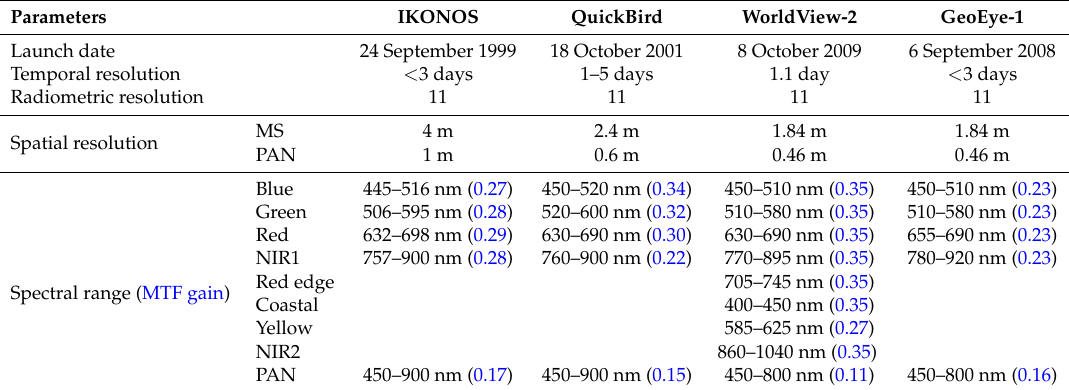
Table 1. Parameters of different satellites. Note that the gains at Nyquist cutoff frequency of the MTFs (MTF gain) are reported in parentheses and in